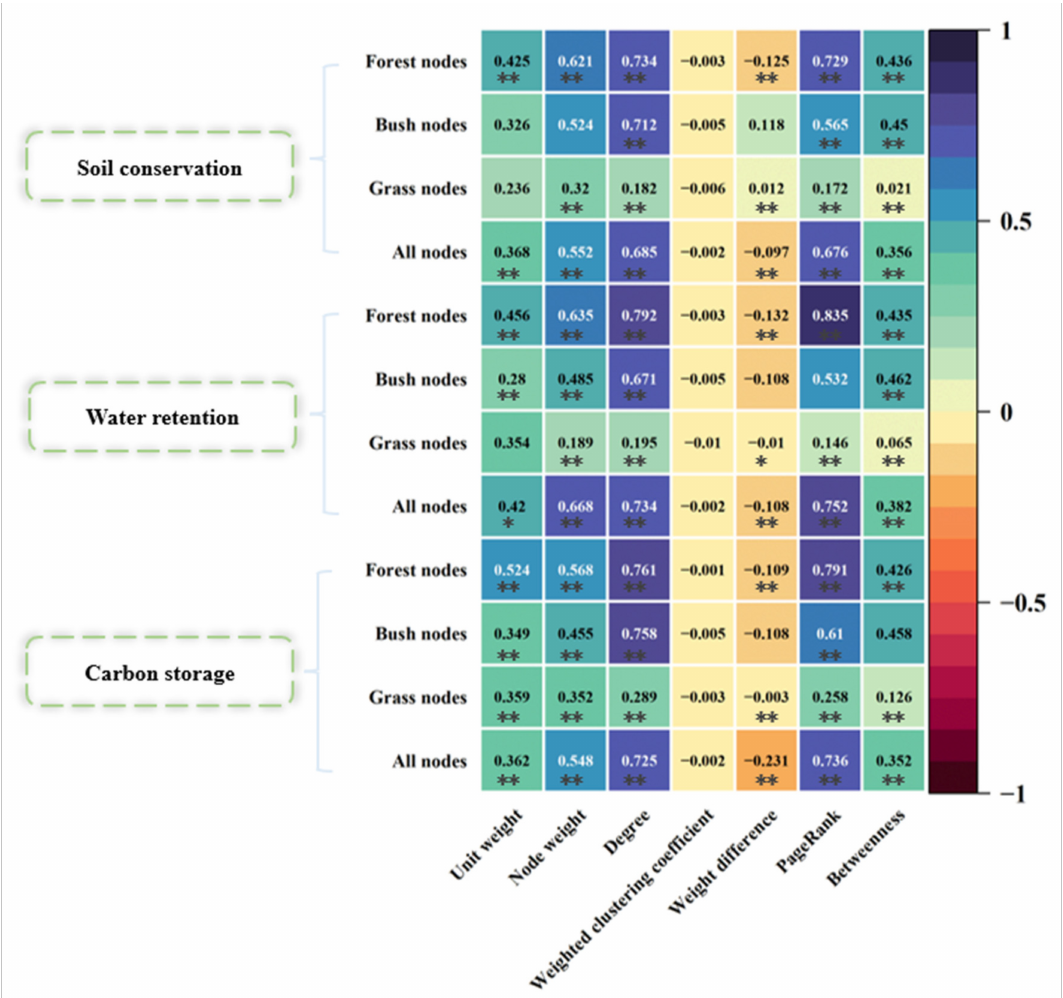
Figure 10. Correlation between topological indicators of eco-space network and ecosystem services. The asterisks donate statistical significance: * p < 0.05, ** p <